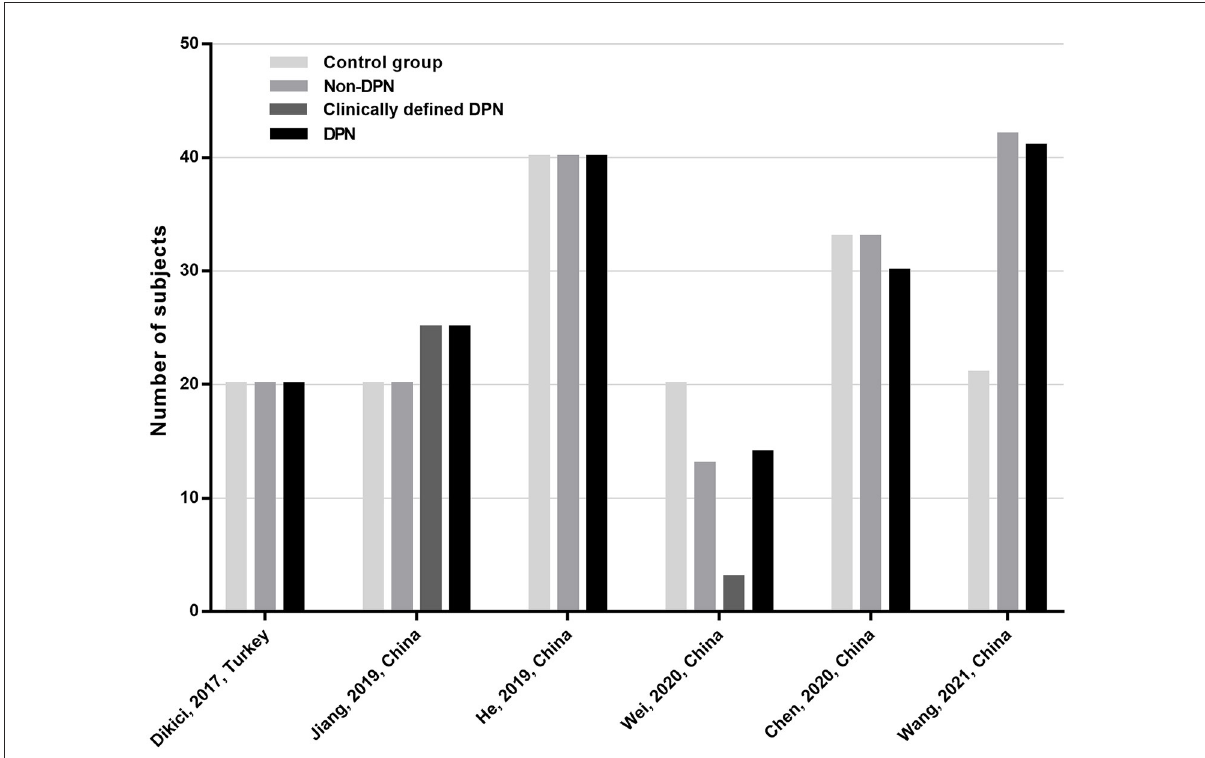
FIGURE2 Distribution of research population of the included